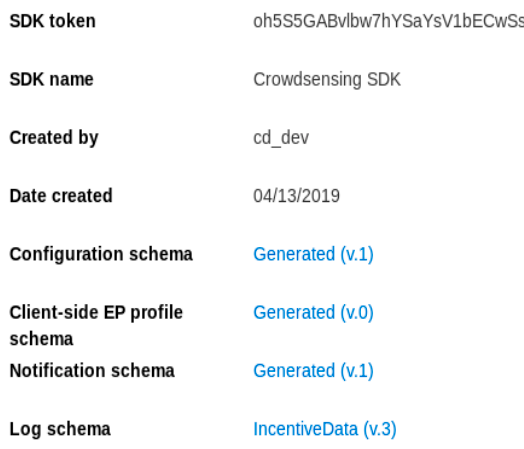
Figure 9. Profile management interface of Kaa SDK.